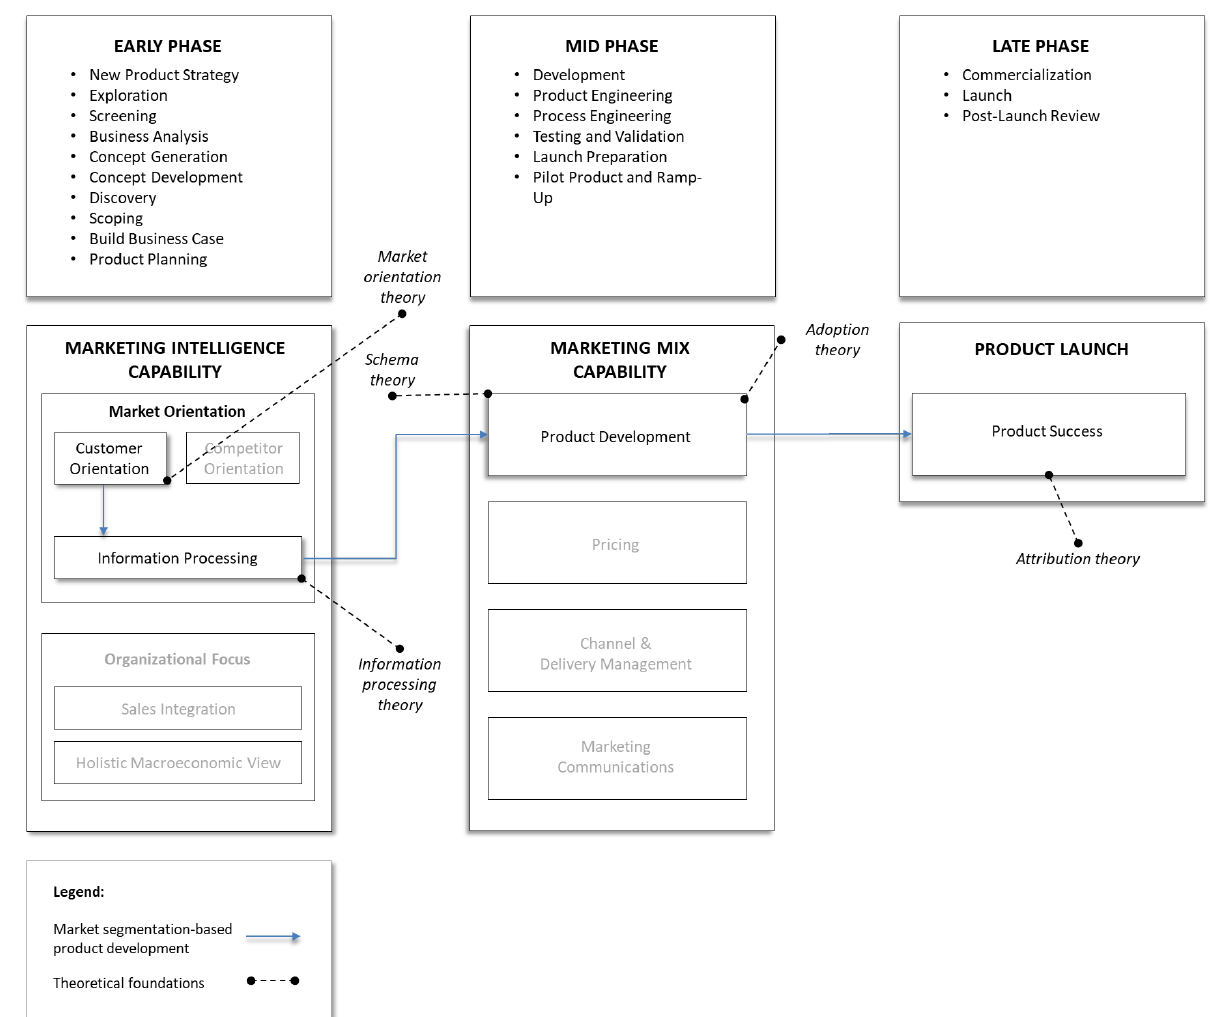
Figure 1. Conceptual model outlining theoretical underpinning of segmentation-based product development.